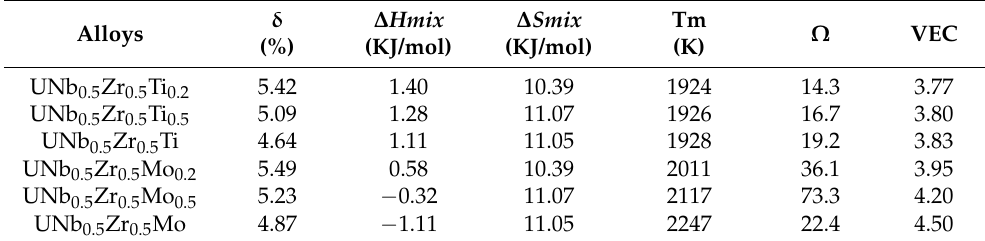
Table 6. Thermodynamic parameters of UNb 0.5 Zr 0.5 -X